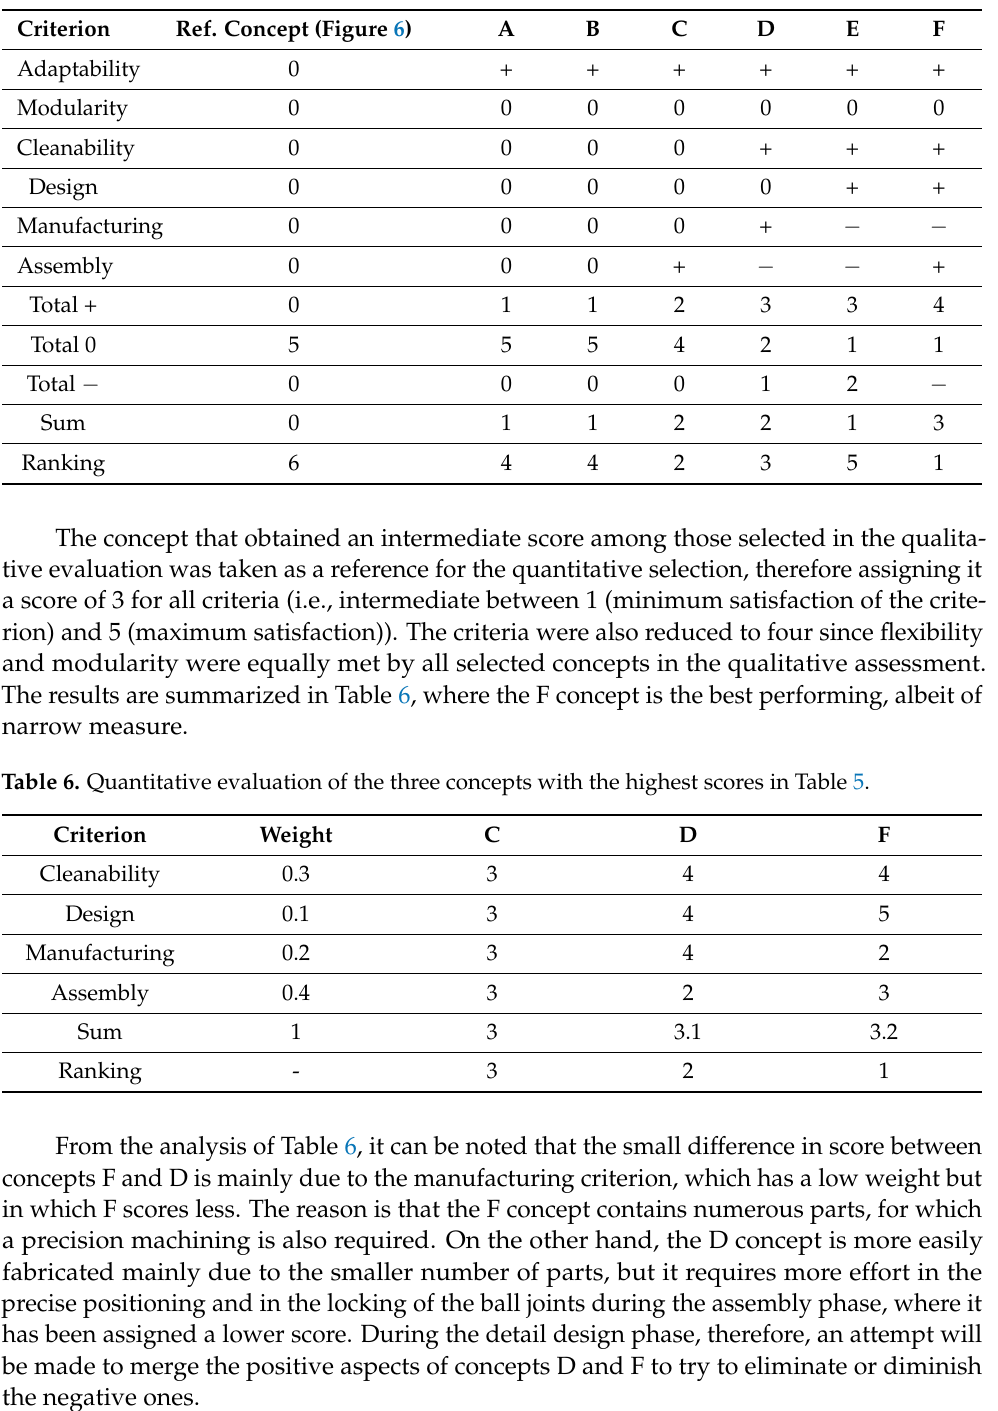
Table 5. Qualitative evaluation of the concepts (better (“+”), equal (“0”), or worse (“ − ”) than the reference concept).